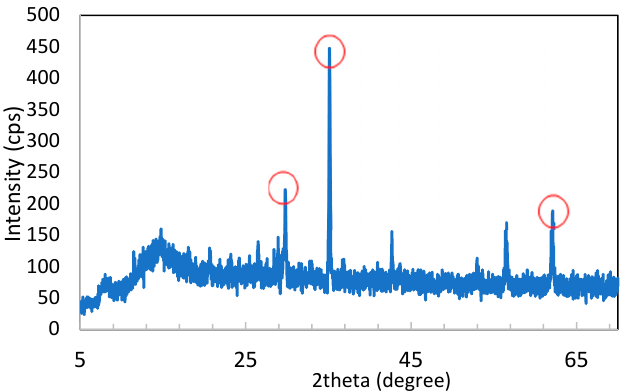
Figure 2. XRD spectrum of zinc ferrite and highlighted peaks attributable to the Franklinite